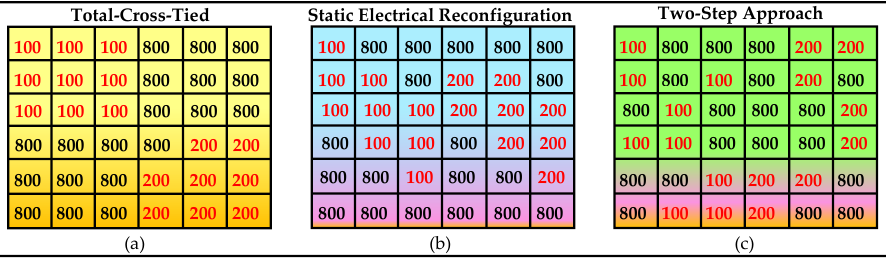
Figure 14. Irradiance received by the 6 × 6 PV array during partial shading S5 for ( a ) conventional, hybrid and TCT, ( b ) static electrical reconfiguration (shade dispersion), and ( c ) the two-step approach (shade dispersion).